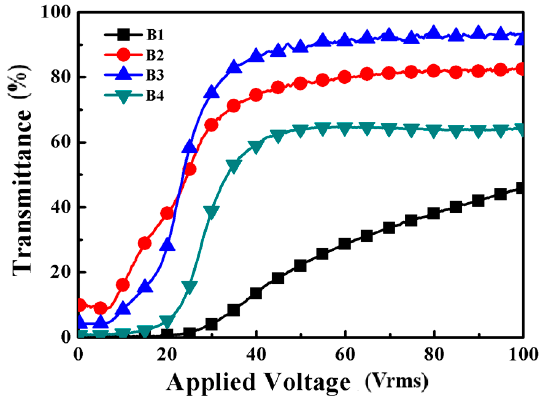
Figure 5. The transmittance-applied voltage curves of samples B1–B4. Animals 2017 , 7 , 317